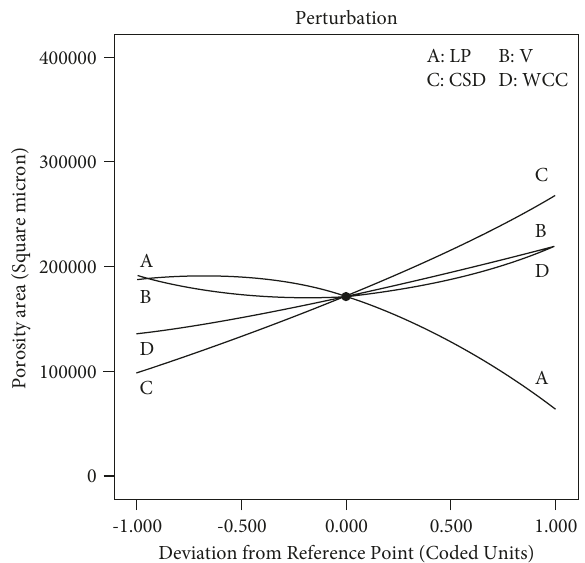
Figure 5: Perturbation diagram of the porosity area by process parameters.